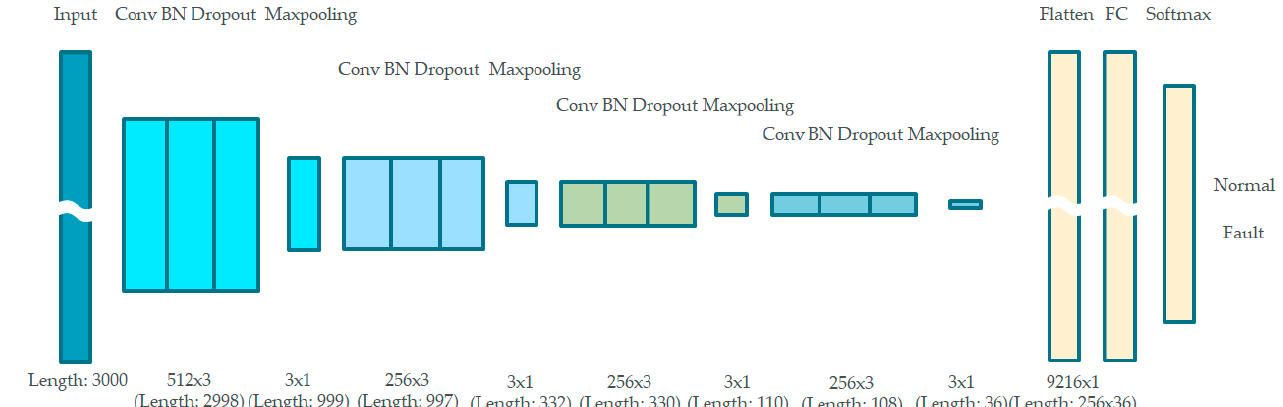
Figure 12. Detailed configuration of 1D CNN model.